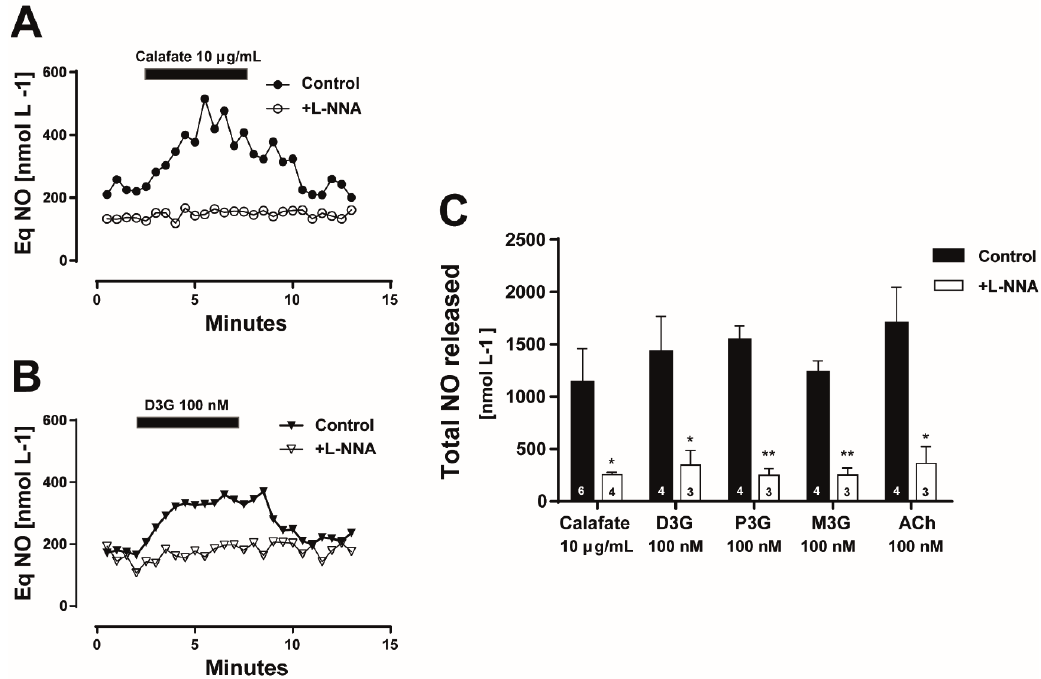
Figure 5. Luminally accessible NO determinations elicited by Calafate extract perfusion or the main anthocyanins. ( A ) Representative time course of NO released to the perfusate following 10 µg/mL Calafate extract application (closed symbols) and following eNOS blockade with 150 µM L-NNA (open symbols) in the same preparation. ( B ) Representative time course of luminally accessible NO elicited by perfusion with 100 nM of delphinidin-3-glucoside (D3G) in a control preparation (closed symbols) and following L-NNA (open symbols). ( C ) Statistical analysis of NO production elicited by perfusion with 10 µg/mL Calafate extract, 100 nM delphinidin-3-glucoside (D3G), petunidin-3- glucoside (P3G), malvidin-3-glucoside (M3G) and acetylcholine (ACh) before and after treatment with the enzyme inhibitor. Columns represent the mean values; bars the SEM. The number inside the columns represents protocol repetitions in separate mesenteries. *, p < 0.05; **, p < 0.01.